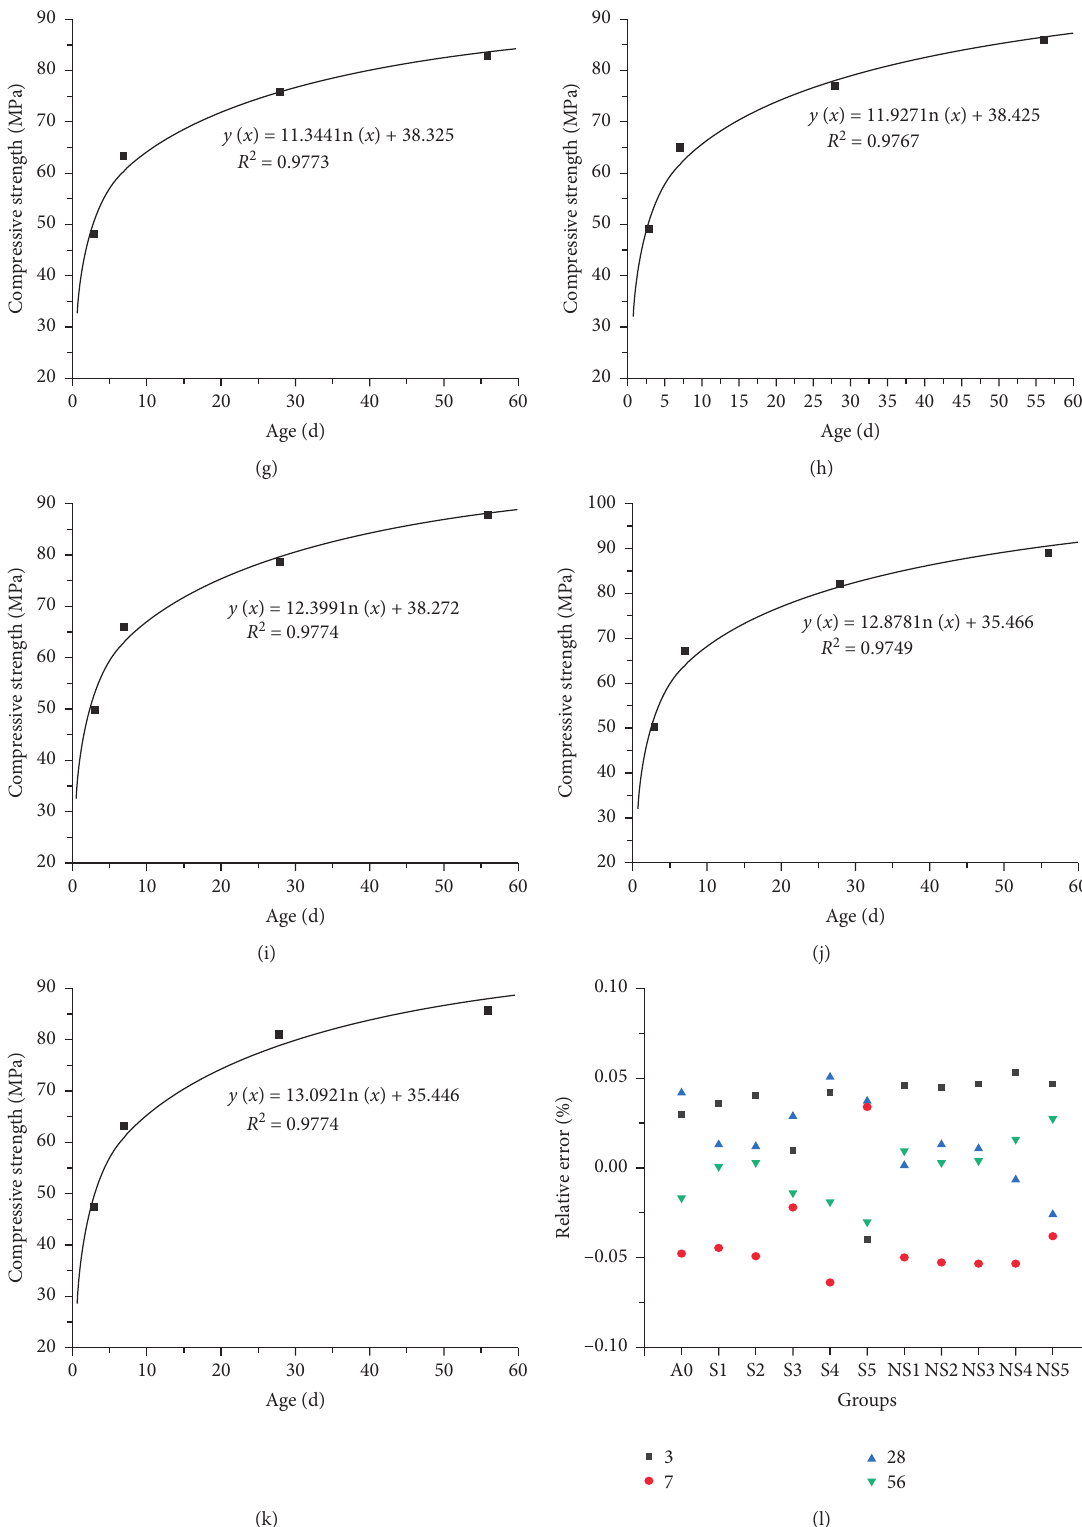
Figure 6: Prediction models and relative error of SF and NS on the compressive strengths. (a) A0 (0%). (b) S1 (5% SF). (c) S2 (10% SF). (d) S3 (15% SF). (e) S4 (20% SF). (f) S5 (25% SF). (g) NS1 (0.5% NS). (h) NS2 (1% NS). (i) NS3 (1.5% NS). (j) NS4 (2% NS). (k) NS5 (3% NS). (l) The relative